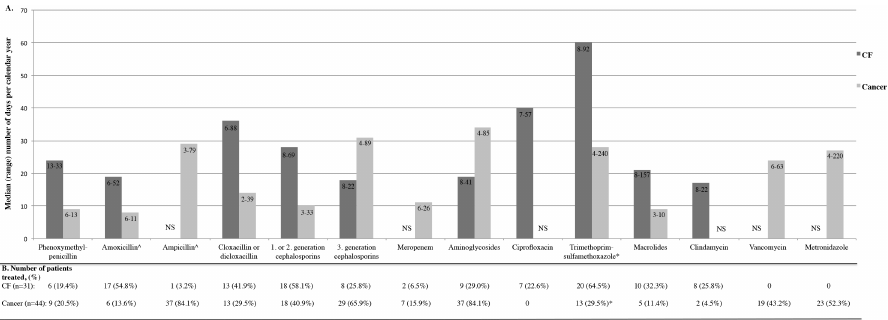
Fig 1. Antibiotic treatment in 31 children with cystic fibrosis (CF) and 44 children with cancer. (A) Median(range, shown inside the columns) numberof days per calendaryear with antibiotic treatment in the study periodamongpatients who receivedat least one course of treatment. For some antibiotics, median numberof days is not shown (NS) due to no or only one or two patients treated. (B) Number of patients (%) in each patient group treated with at least one course of the antibiotic. For one of the 32 CF patients and for one of the 45 cancer patients includedin the study no antibiotic treatment was registeredsince a faecal sample was providedonly at the time of inclusioninto the study. ^Amoxicillin was only administered orally and ampicillinwas only administered intravenously. * Prophylactic treatment given to cancer patients is not